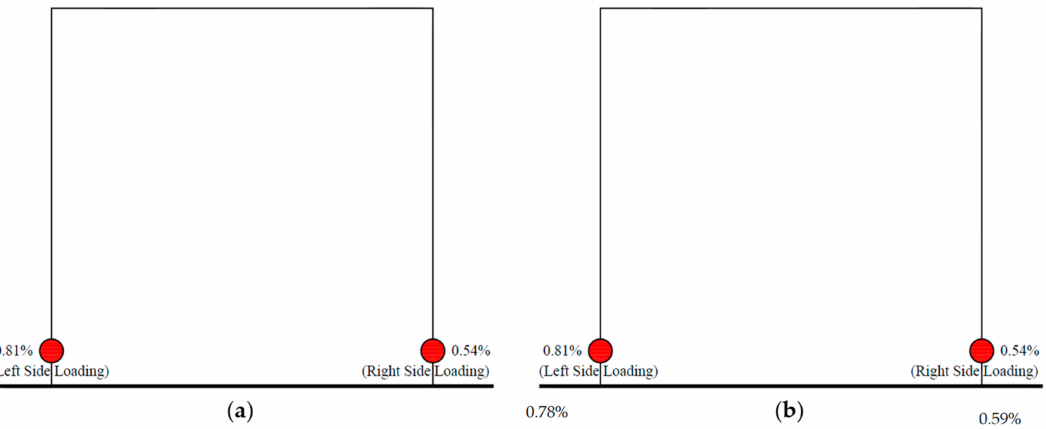
Figure 11. Locations of reinforcement yielding and corresponding drift values ( a ) OPC-CM ( b ) GPC-CM.